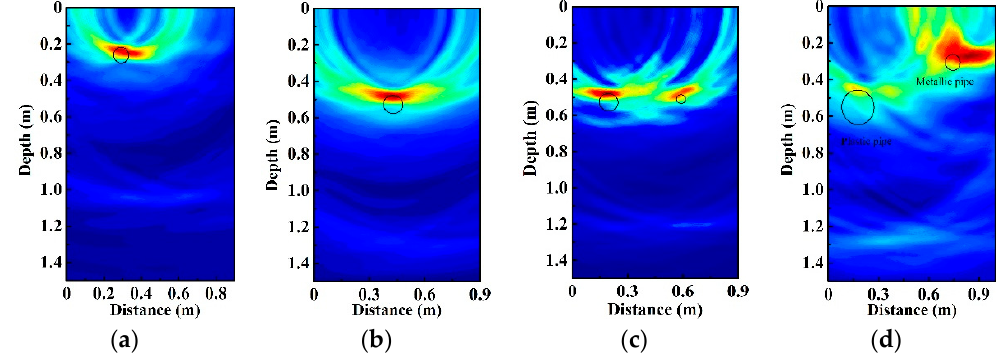
Figure 6. The radar profile of buried metallic pipes. ( a ) The position of metallic pipe 1 is at (0.30, 0.20) m. ( b ) The position of metallic pipe 1 is at (0.43, 0.45) m. ( c ) The positions of metallic pipe 1 and metallic pipe 2 are at (0.18, 0.50) m and (0.58, 0.50) m. ( d ) The radar profile of the two different type pipes.